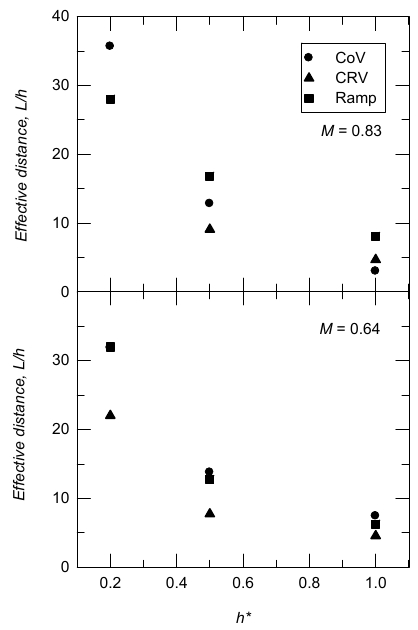
Figure 14. Effective distance, L / h Figure 14. E ff ective distance, L/h .